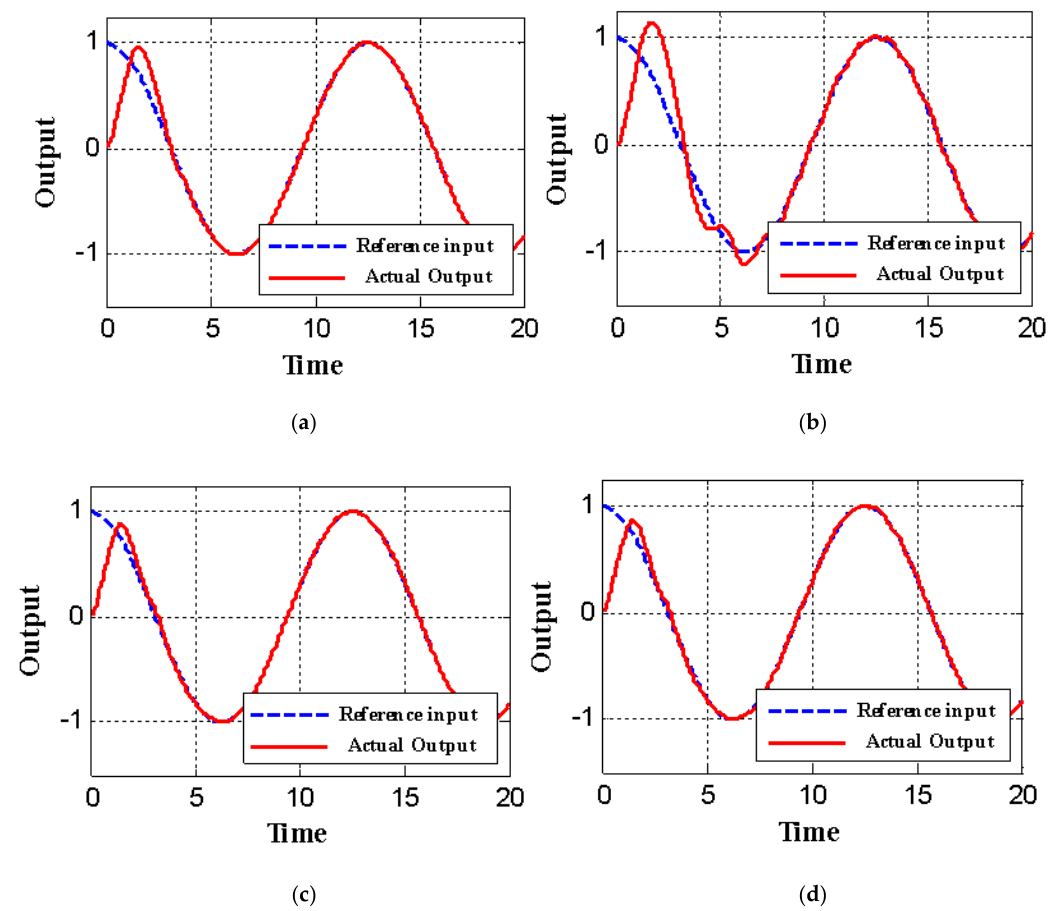
Figure 3. The output response curves (y). ( a ) Conventional ADRC (C-ADRC) (without measurement noise), ( b ) C-ADRC (with measurement noise), ( c ) N-ADRC (without measurement noise), ( d ) N- ADRC (with measurement noise).